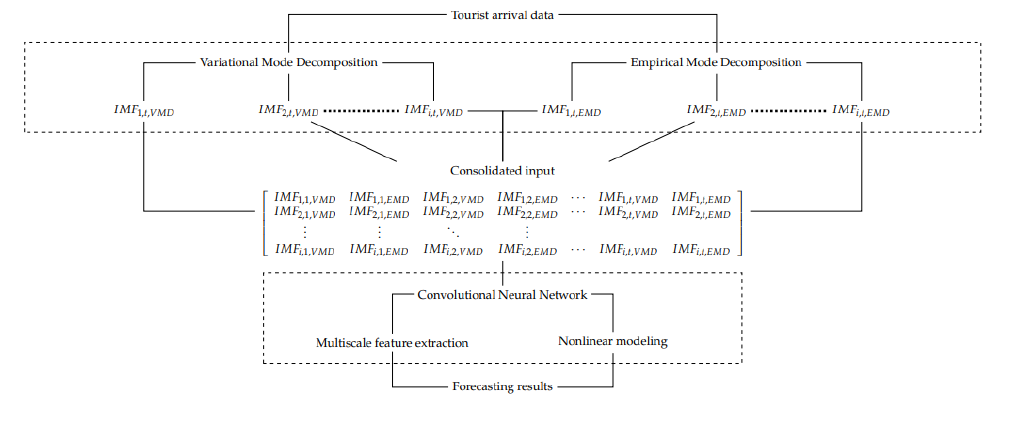
Figure 1. Flowchart for the MD-CNN